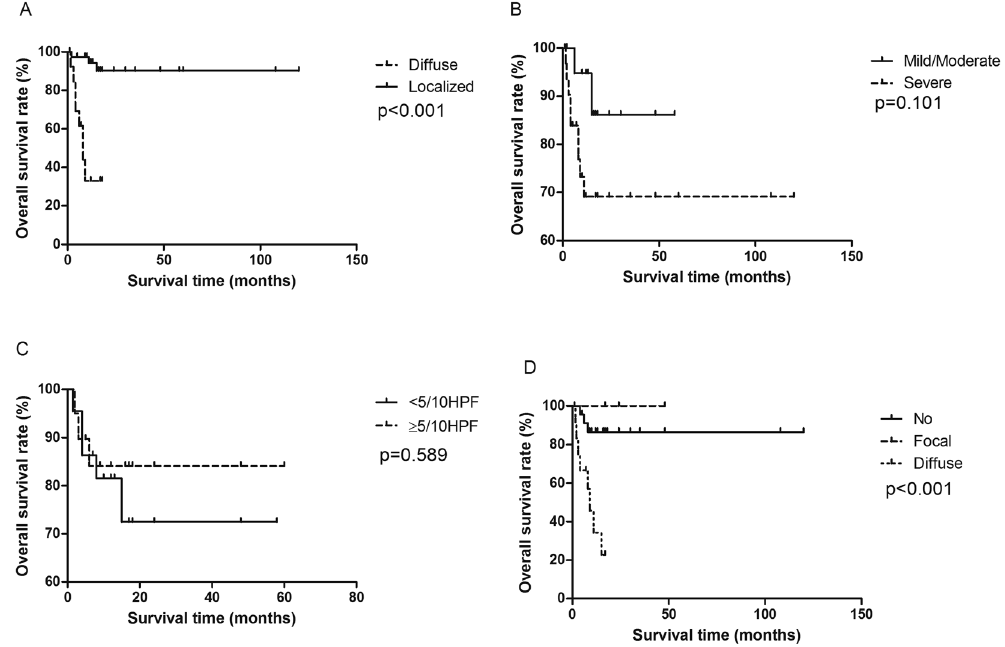
Figure 7. Tumor stage was associated with a shorter OS significantly ( A ). Nuclear abnormalities and mitosis were not related with OS ( B , C ). Patients with no or localized necrosis did not get median OS, compared with patients with diffused necrosis having a 9-month median OS ( D ) (p < 0.001).